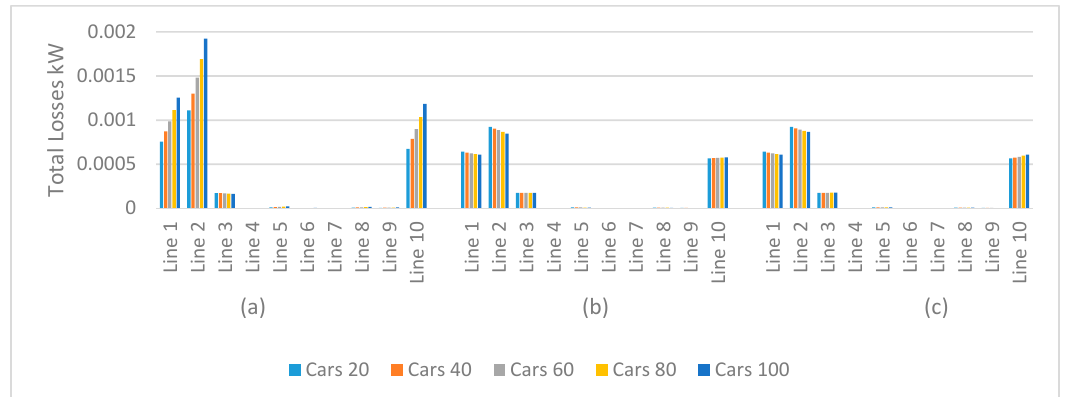
Figure 17. Average line losses observed—( a ) unoptimized versus, ( b ) optimized for minimizing total (sum) of line losses in the entire across all cables with no limit on confiuguration versus, ( c ) across all cables per vehicle with with no charging station having more than 25% of the vehicles charging at that hour.